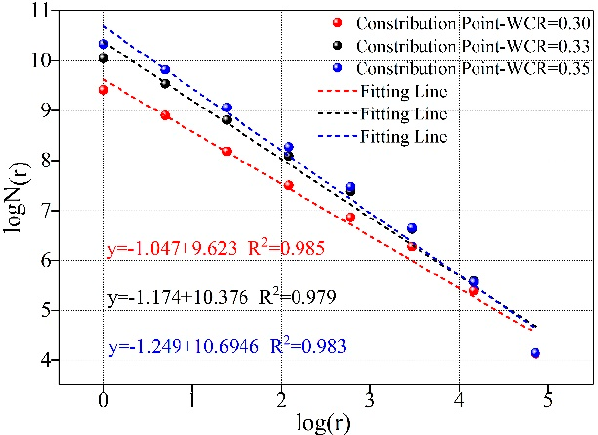
Figure 5. Fractal dimension calculation of rock-like materials under different WCR.